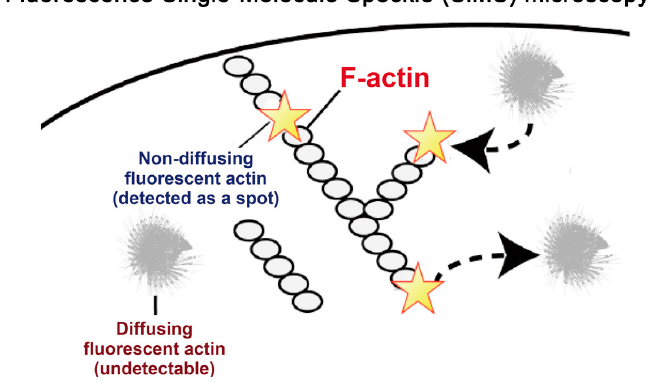
Figure 1. A schematic diagram of the principles of Single-Molecule Speckle (SiMS) microscopy.When the expression level of EGFP-actin is sufficiently low, signals from EGFP-actin assembled with F-actin add up in a small spot on the CCD with long exposure time. In contrast, signals from a freely diffusing EGFP-actin in the monomeric form are blurred on the image.